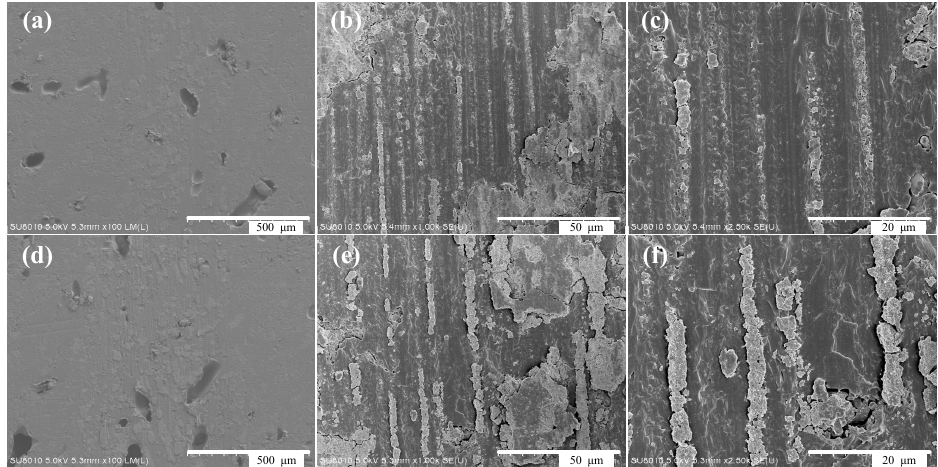
Figure 14. ( a – c ) Surface wear morphology of composites under dry friction at 1 N, 200 r/min; and ( d – f ) 3 N, 300 r/min with different magnification.